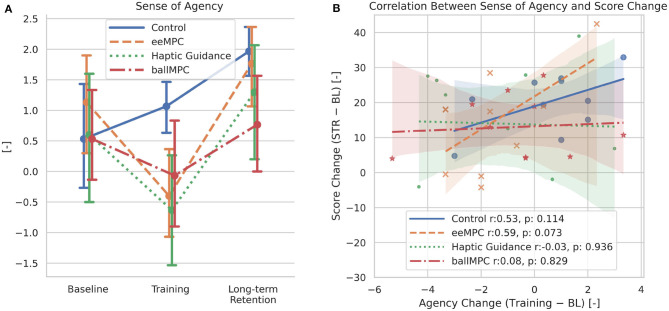
(A) Effect of the training strategy on changes in responses to the agency questionnaire from baseline to after training and long retention test. (B) Association between the change of sense of agency and score increase from baseline to short term retention. Error bars indicate the 95% confidence interval.